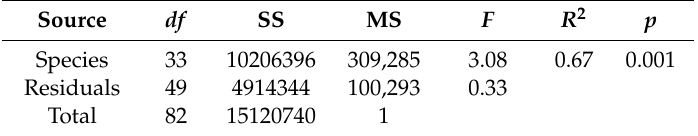
Table 1. Test for species di ff erences in phosphorus (P) organic compound content in leaf material.